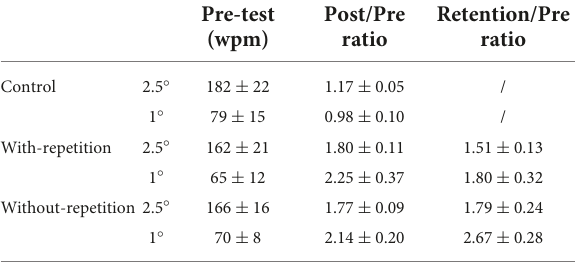
TABLE 1 Pre-test performance and performance change (mean ± SEM) in Rapid Serial Visual Presentation (RSVP) reading speed for the control group and the two training